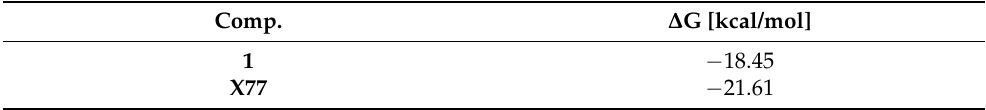
Table 5. Binding free energies ( ∆ G in kcal/mol) of jusan coumarin and the co-crystallized ligand against M pro